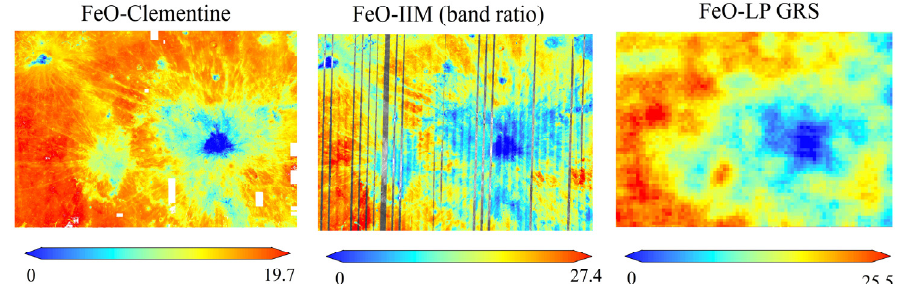
Figure 15. Distribution of FeO based on different data/methods. Table 5. Correlation coefficients based on different data/methods for FeO inversion.